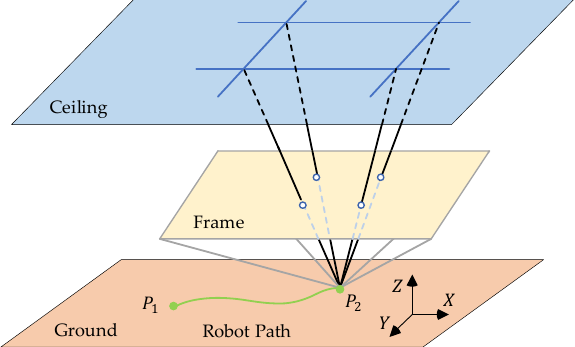
Figure 1. The observation target of the ceiling-view VO method is the ceiling that contains texture and structural constraints. The camera moves horizontally on the ground, and its motion trajectory is approximately parallel to the ground plane and the ceiling plane. In such a scene, the surrounding obstacles will not block the observed ceiling.